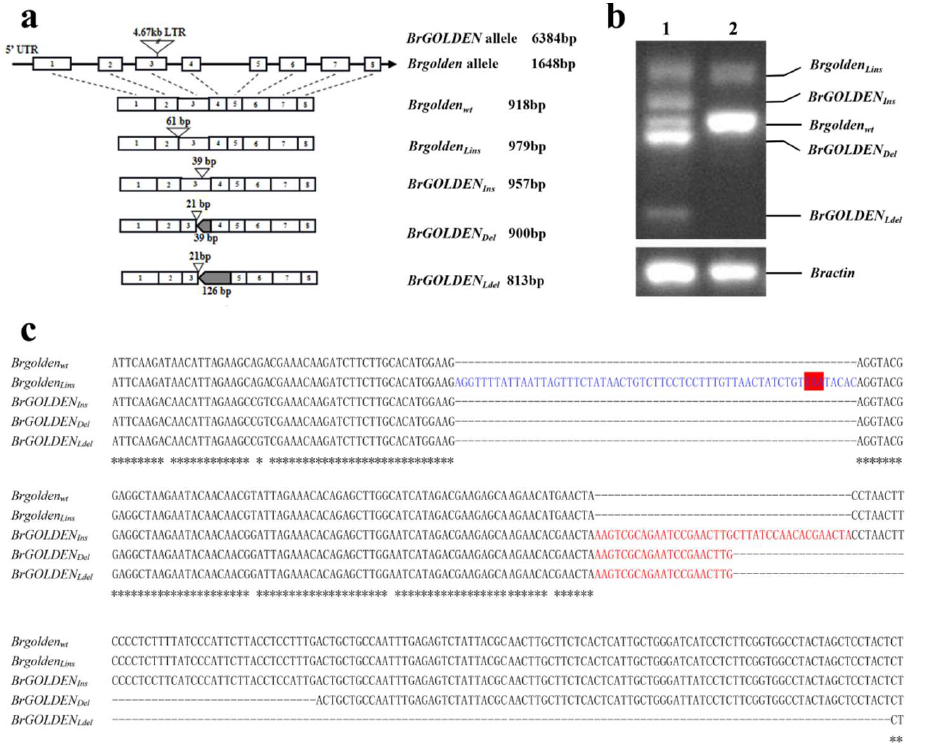
Figure 5. BrGOLDEN structure analysis. ( a ) The BrGOLDEN with the 4.67 kb LTR insertion site and different transcripts. Open boxes with numbers represent exons and solid lines represent introns. Triangles indicate insertion sites and grey boxes indicate deletion sites. Brgolden Lins , large insertion; BrGOLDEN Ins , insertion; BrGOLDEN Del , deletion; BrGOLDEN Ldel , large deletion. ( b ) RT−PCR amplification of BrGOLDEN in the ‘1900264′ (lane 1) and ‘1900262′ lines (lane 2) cDNAs. Bractin served as an internal control. ( c ) Nucleotide sequence alignment of five transcript fragments. The blue words represent the transcripts resulting from the complete insertion of the second intron in the ‘1900262′ line and the red box indicates the translation end site. The red words and dotted lines indicate the splicing patterns of the three transcripts unique to the ‘1900264′ line.